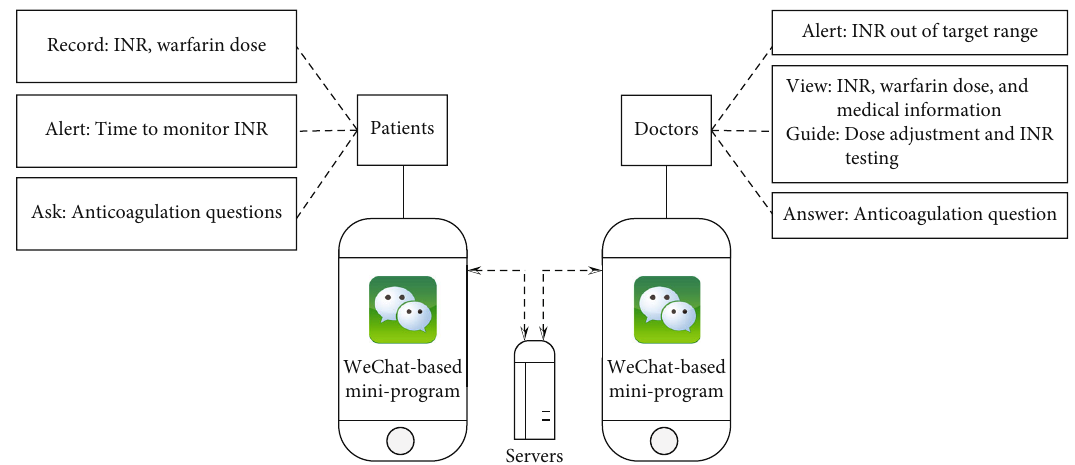
Figure 1: The pattern diagram of warfarin management via WeChat-based miniprogram. INR=international normalized